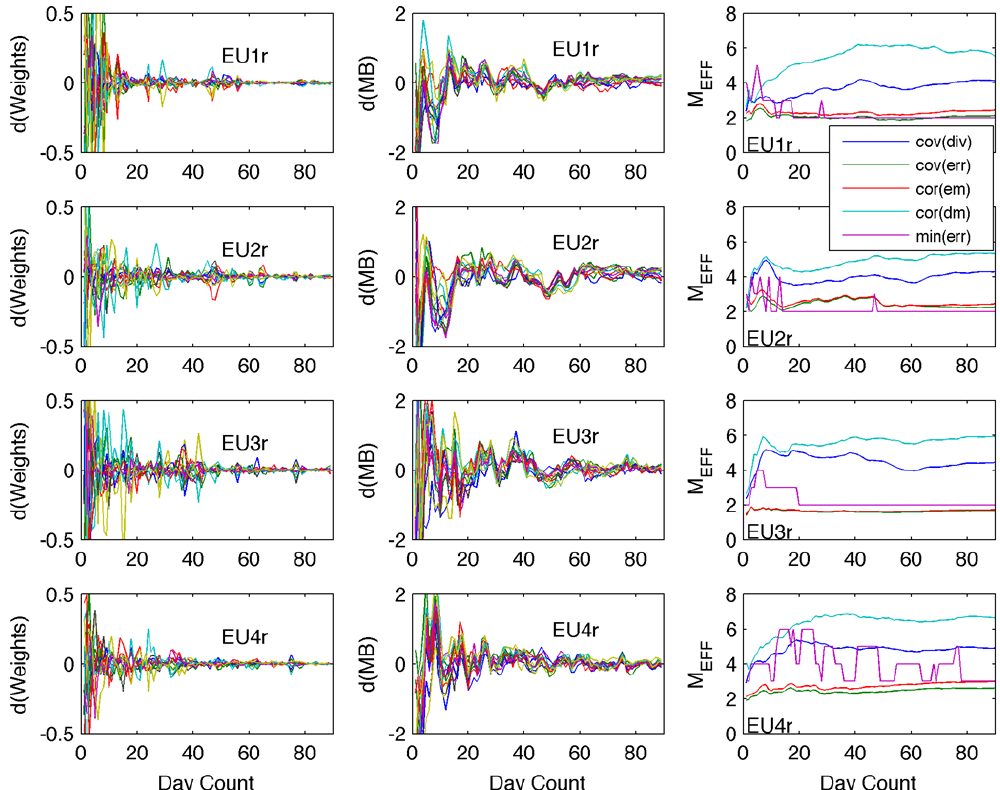
Figure 7. Variability of weights (left column), bias (middle column) and effective number of models (right column) as a function of time- series length. Each thin line represents a different model. The effective number of models is calculated through eigenanalysis and error